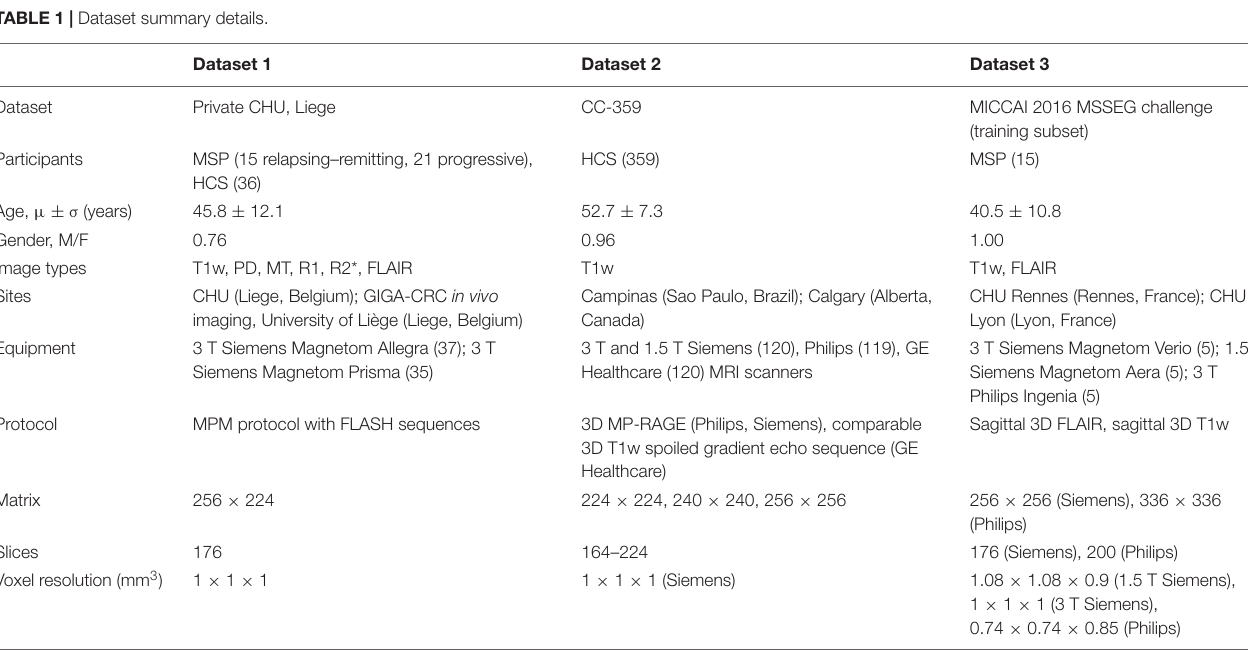
TABLE 1 | Dataset summary